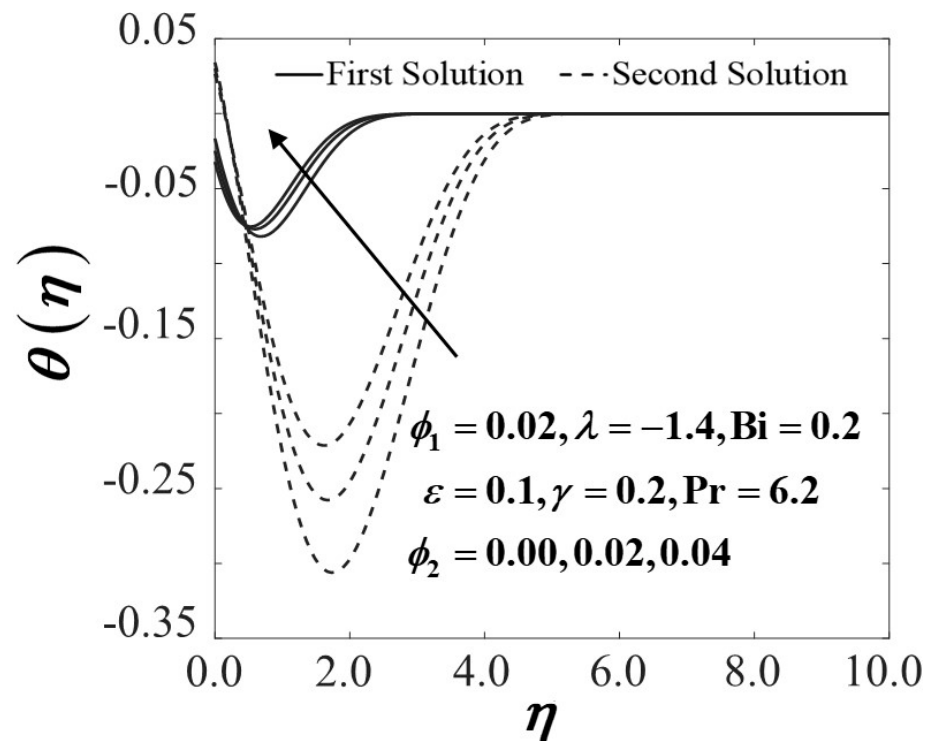
( ) θη with 1.4 λ = − (shrinking case).